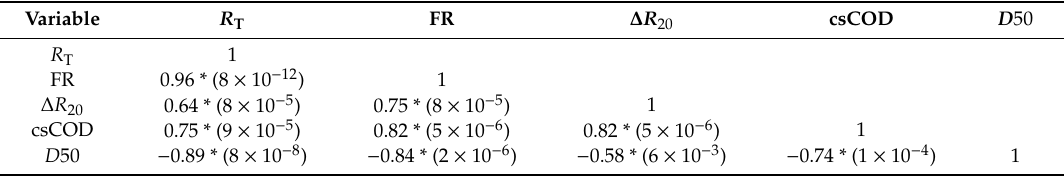
Table 1. Spearman correlation half matrix between sludge characteristics, total filtration resistance ( R T ), fouling rate (FR) and sludge filterability (expressed as ∆ R 20 ). Significant correlation at level 0.01 (*); probability value ( p ) given between